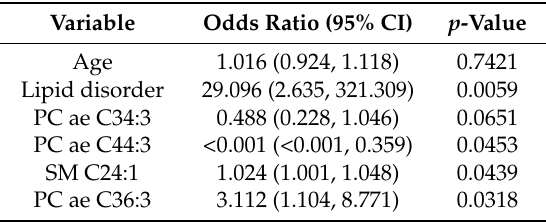
Figure 3. Targeted metabolites were significantly different between control, lipid disorder (LD) and LD with diabetes mellitus (DM) groups. Metabolites in 40 control participants, 3 control with DM participants, 20 LD participants and 19 LD with DM participants were validated with liquid chromatography tandem mass spectrometry. ( A ) Principal component analysis (PCA) and ( B ) orthogonal partial least squares discriminant analysis (OPLS-DA) score plots demonstrated a considerable separation between control, LD and LD with DM groups, however the control with DM group could not be separated from the other groups; ( C ) Receiver operating characteristic (ROC) curve for the predictive model. A combination metabolite model calculated from the logistic regression analysis; ( D ) A schematic diagram illustrating how metabolites change following DM progression from control; metabolites marked in blue refer to those which decreased with DM progression, while metabolites marked in red refer to those which increased with DM progression. Table 2. Multivariate analysis for